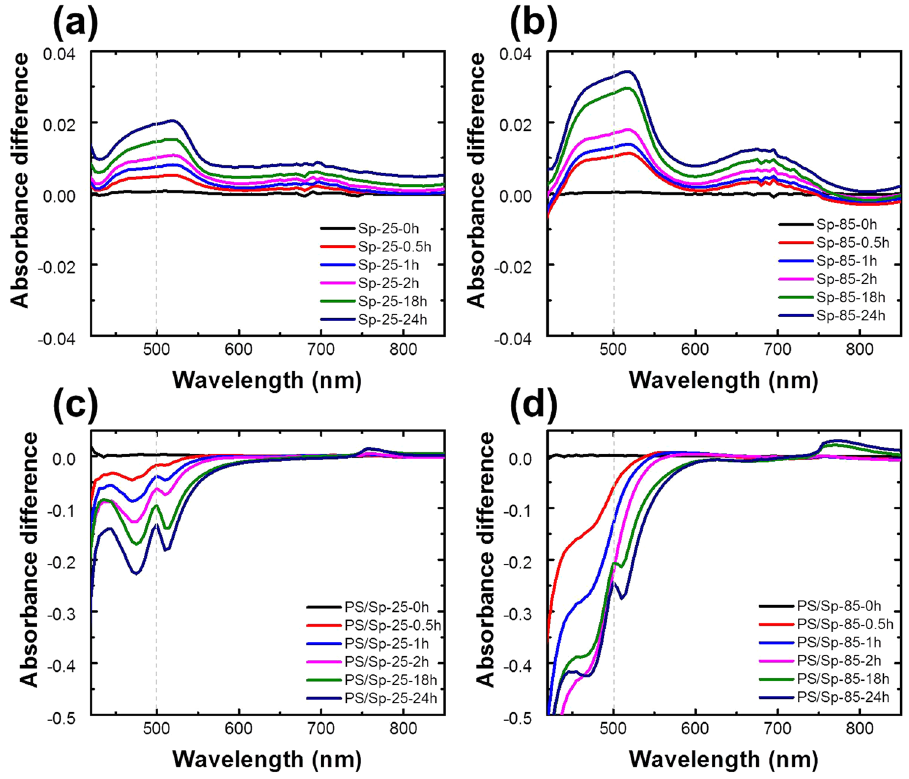
Figure 2. Changes in the absorbance of spiro-OMeTAD at ( a ) 25 °C and ( b ) 85 °C with time. Changes in the absorbance of MAPbI 3 /spiro-OMeTAD at ( c ) 25 °C and ( d ) 85 °C with